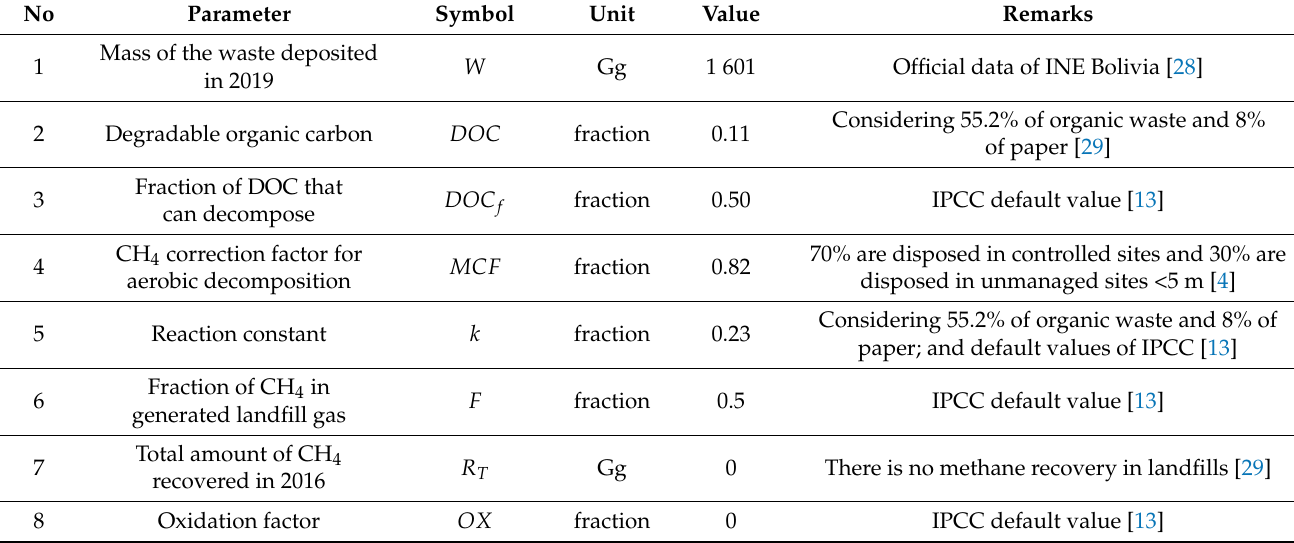
Table 3. Input parameters of solid waste disposal sites in Bolivia